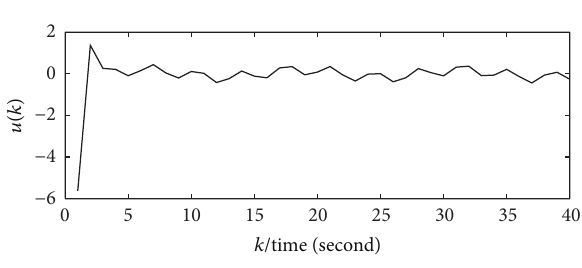
Figure 2: Curves of system input.